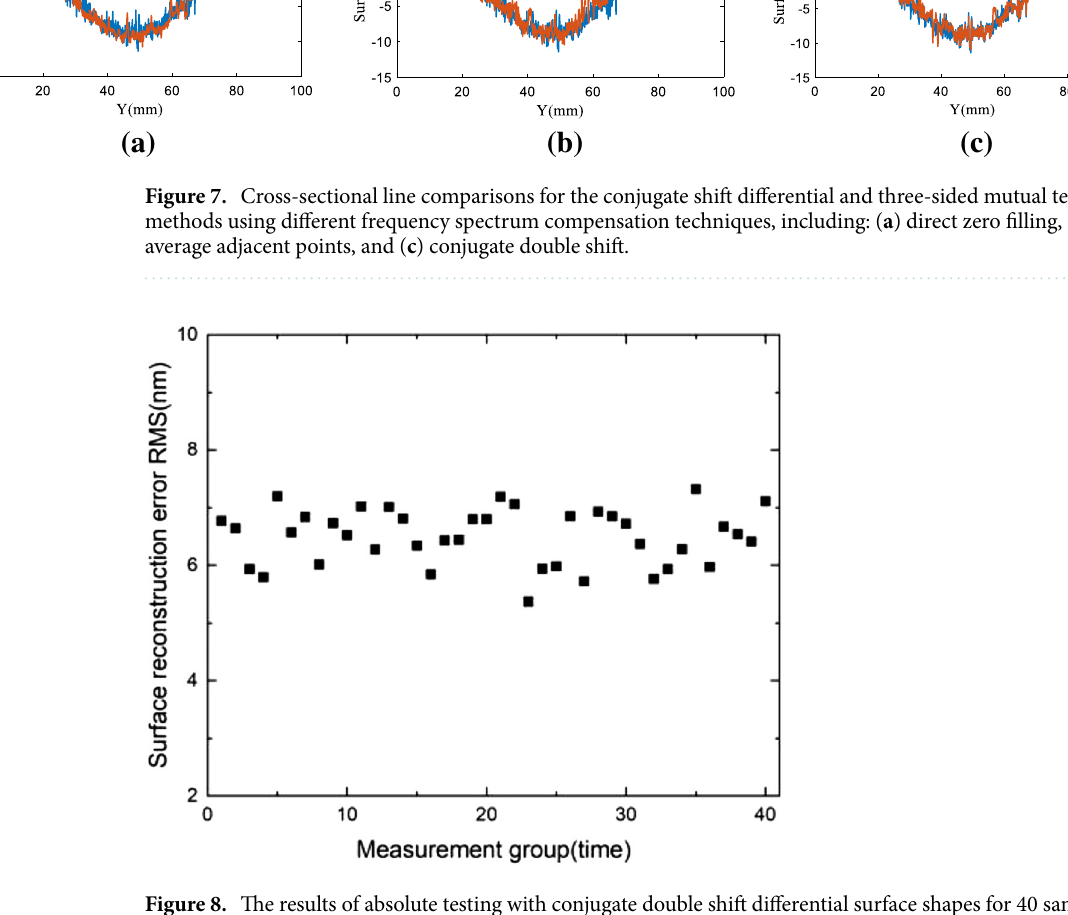
Figure 8. The results of absolute testing with conjugate double shift differential surface shapes for 40